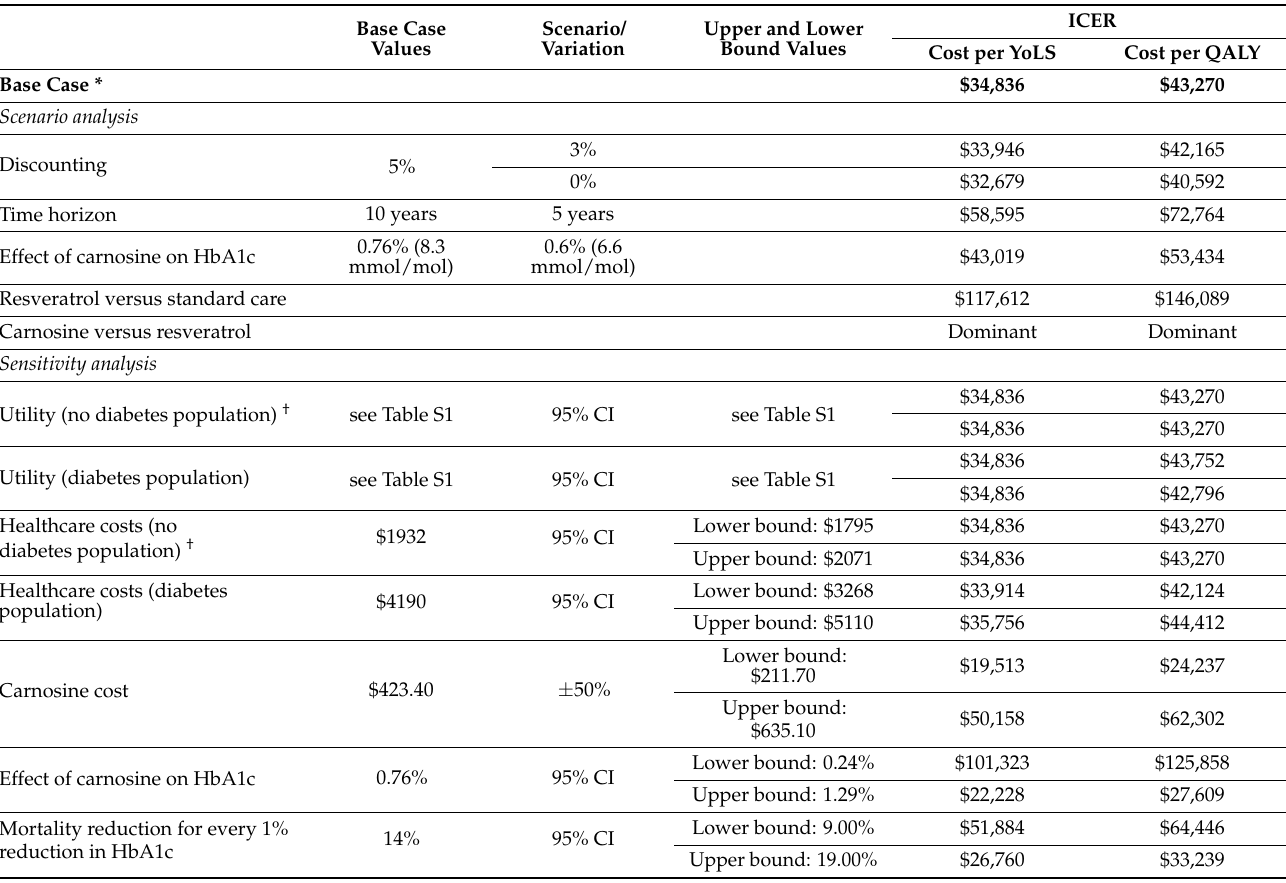
Table 3. Scenario and sensitivity